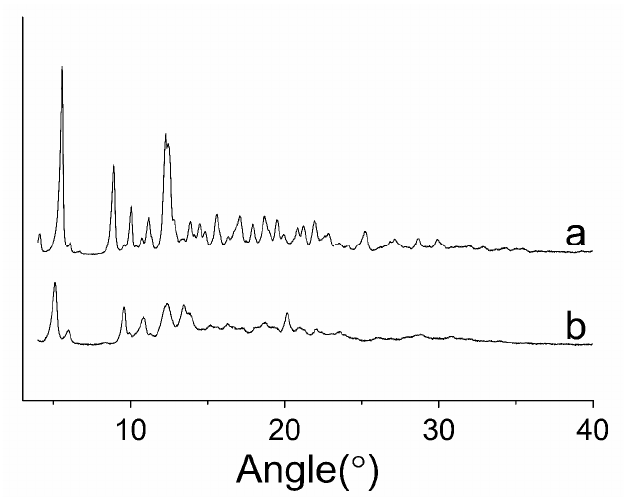
Figure 7. XRD patterns (2 θ = 4–50°) of the samples. ( a ) Raw PTX; and ( b ) PTX crystal powders. Table 1. Analysis date of XRD. Angle( ◦ )